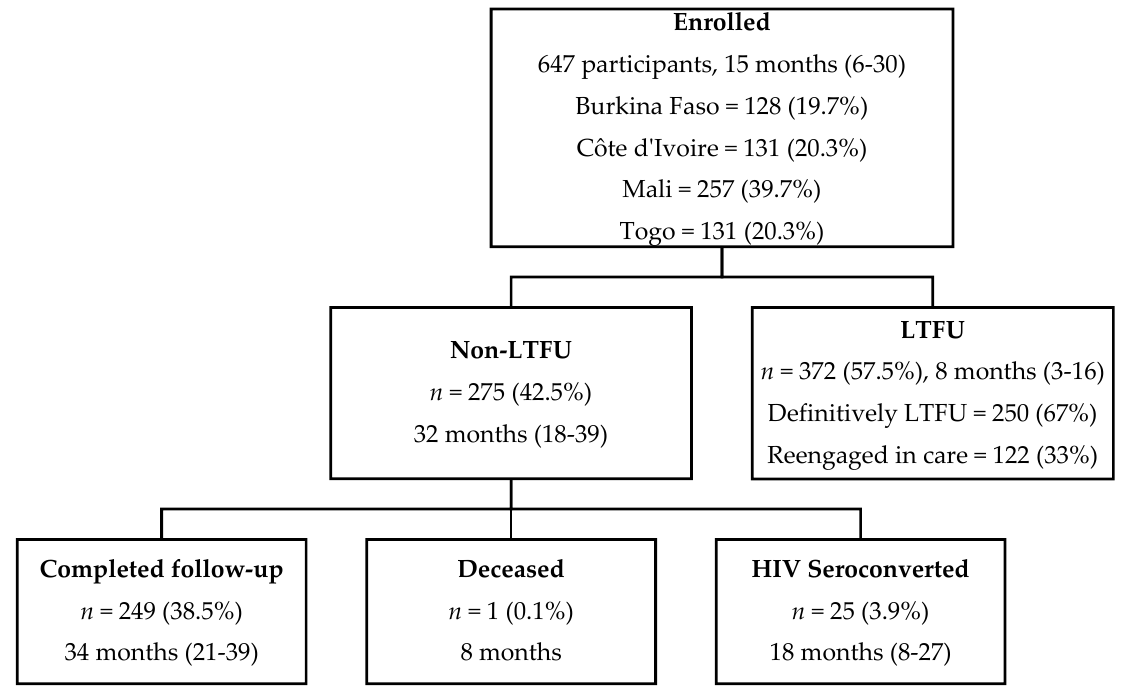
Figure 1. CohMSM-PrEP study population flowchart with median follow-up time in months (IQR) (Follow-up from 20 November 2017–30 June 2021; 647 participants contributed to 4831 visits from baseline to